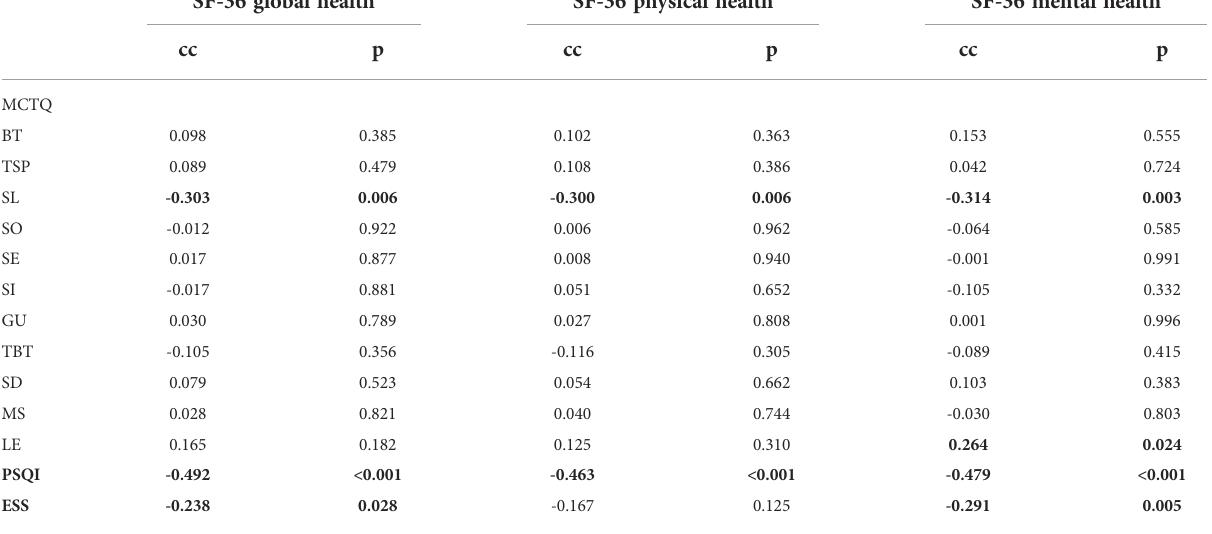
TABLE 3 Correlation analysis of sleep parameters and sleep quality with